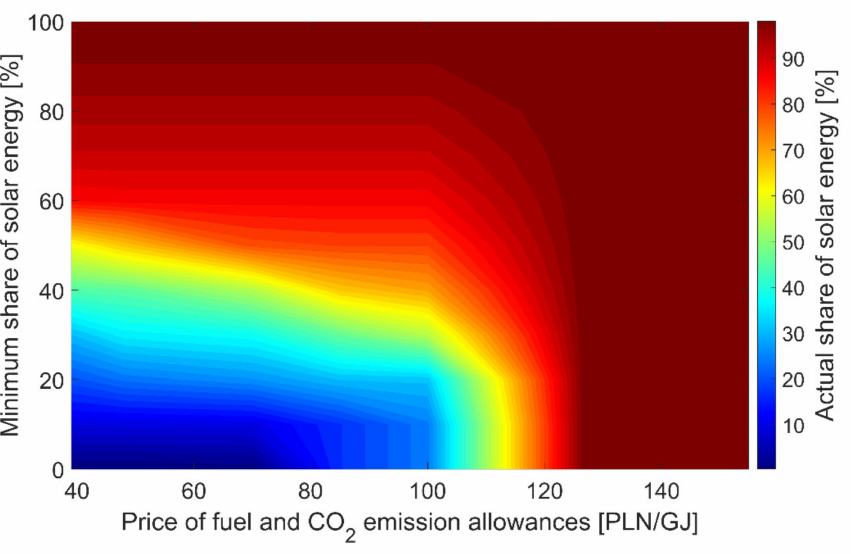
Figure 10. Actual share of solar energy in the system as a function of the required share of solar energy and the cost of purchasing fuel and CO 2 emission allowances for a gas heating